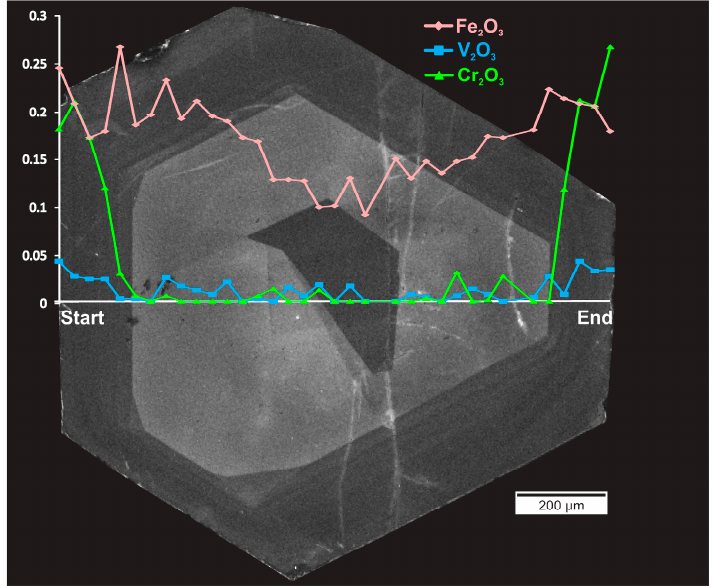
Figure 3. Electron microprobe data for FeO, Cr 2 O 3 , and V 2 O 3 superimposed on a cathodoluminescence image of the emerald shown in Figure 2. The emerald displays multiple growth zones including a partially resorbed core. The outer zones are dark in CL and correspond to enriched concentrations of FeO, Cr 2 O 3 , and V 2 O 3